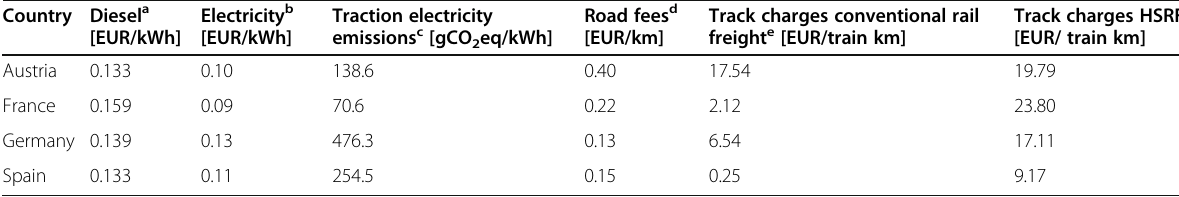
Table 1 Country specific parameters: prices and emissions for 2030